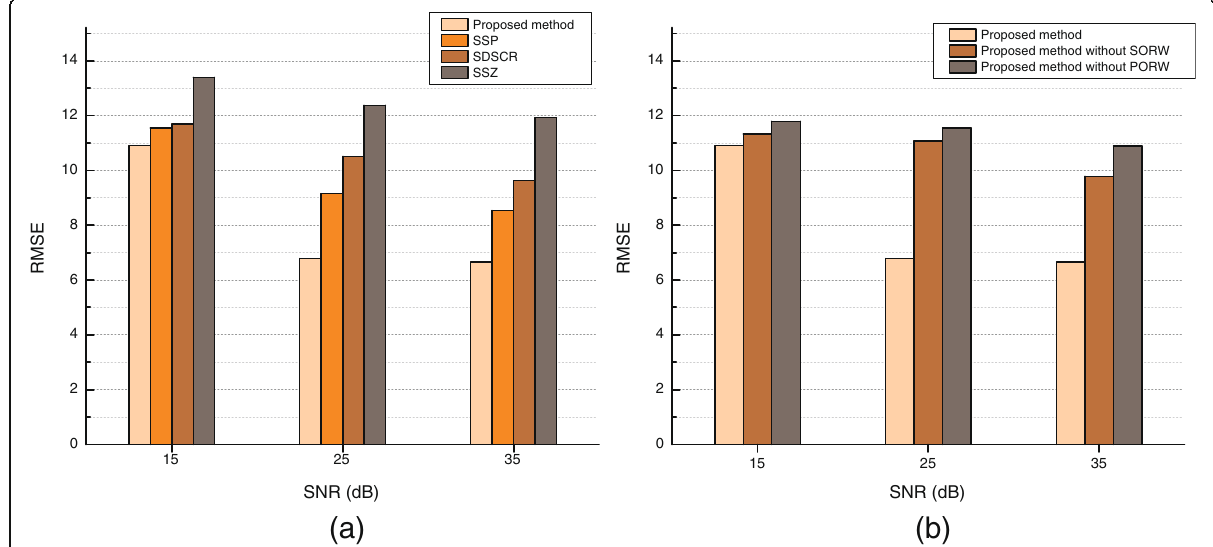
Fig. 11 RMSE of localization results by using signals with different SNR, RT60 = 450ms, three sources, separation between adjacent sources is 60°. a The RMSE of localization results using different methods. b The RMSE of localization results using different proposed